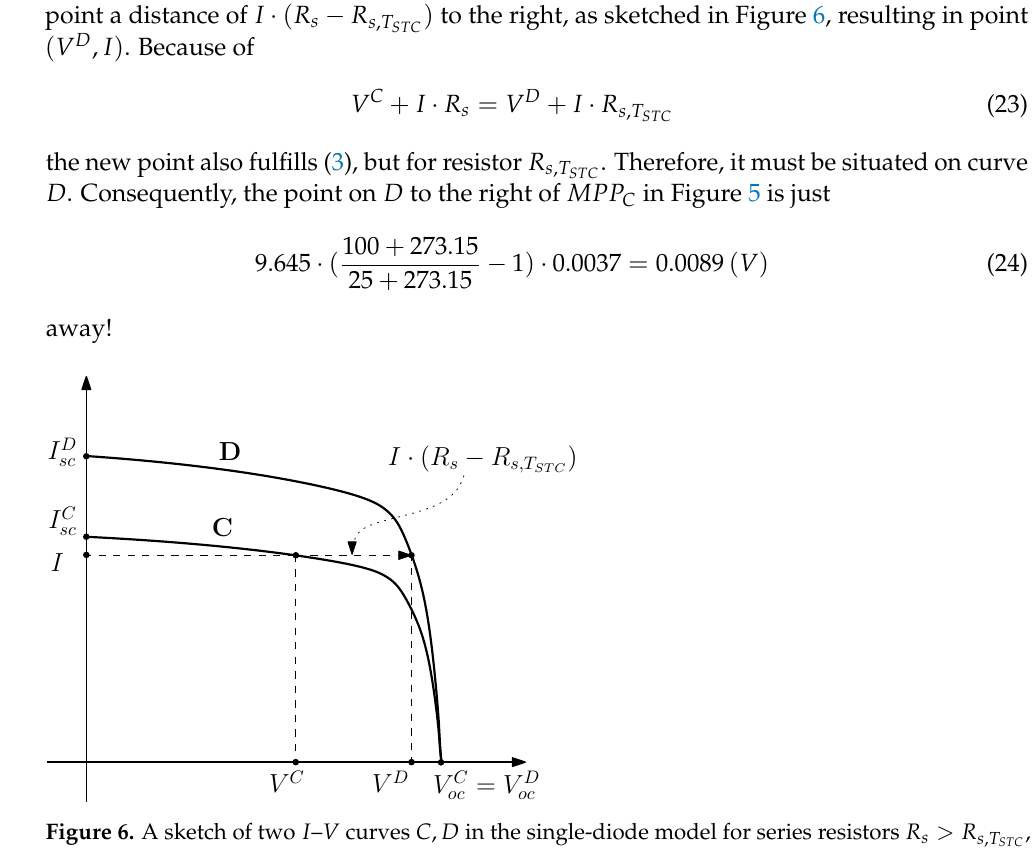
, as with C = C IV , t . T STC